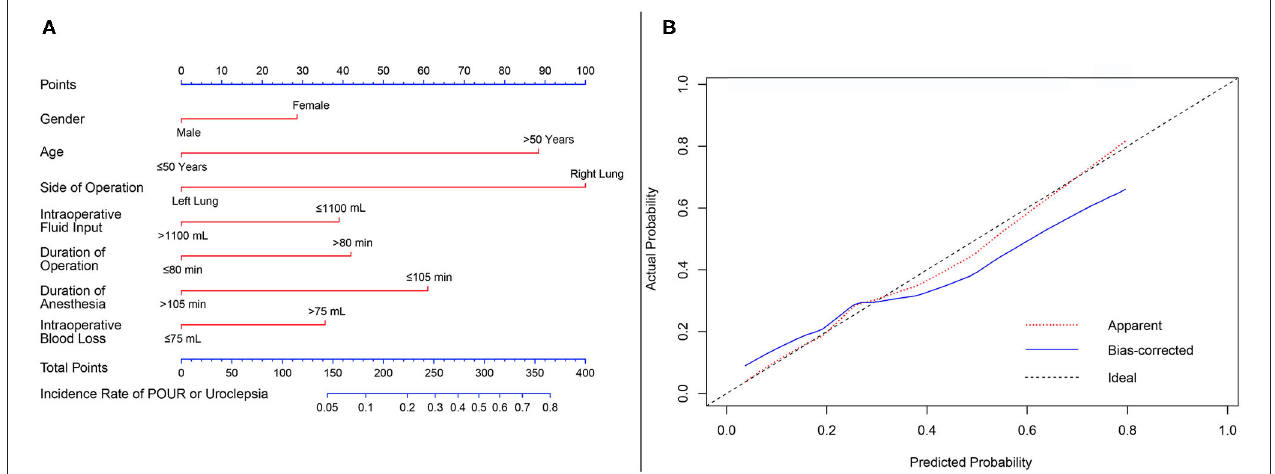
FIGURE 5 | Nomogram predicting the risk of non-automatic micturition in the tubeless group. (A) Nomogram predicting the probability of non-automatic micturition; (B) calibration curves for the nomogram. min, minutes; mL, milliliter.